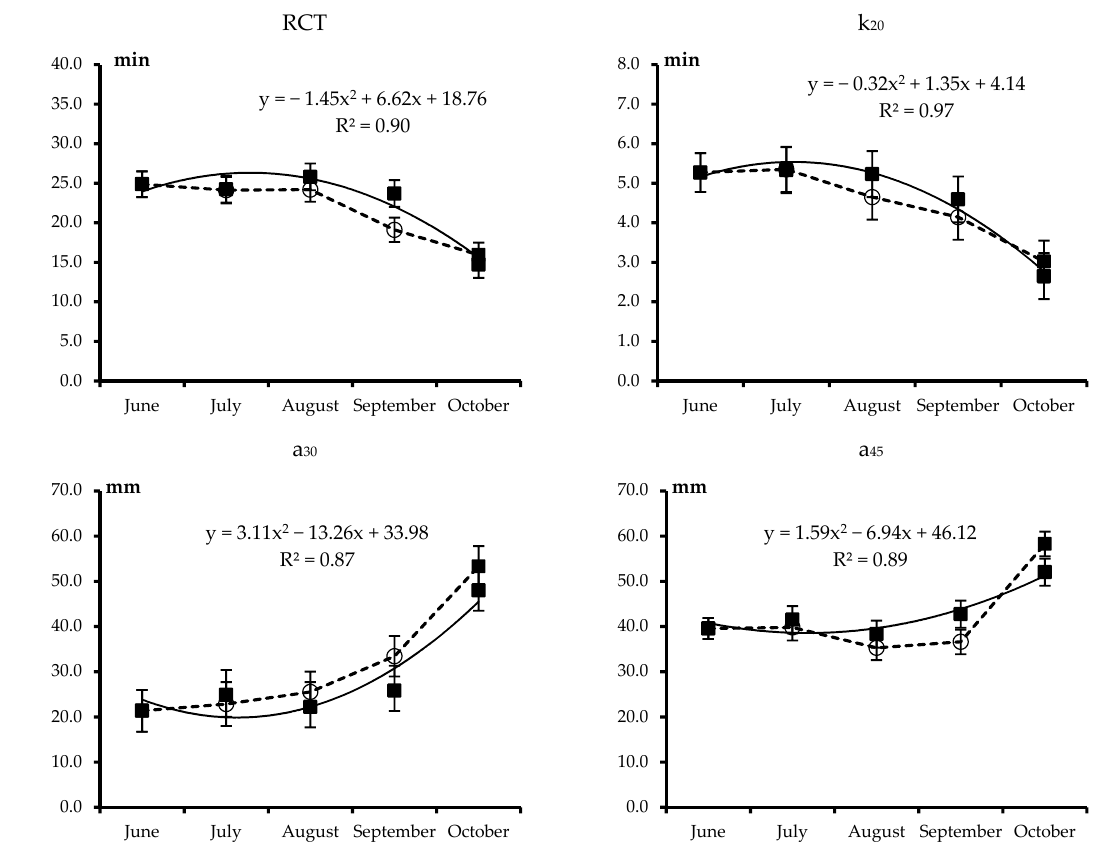
Figure 2. Least squares means and standard error of the combined Treatment × Month effect for milk coagulation traits (RCT: Rennet coagulation time, k 20 : Curd-firming rate as time to a curd firmness of 20 mm, a 30 and a 45 , respectively: Curd firmness after 30 and 45 min from rennet addition) of Brown Swiss cows kept on the permanent farm ( ■ and continuous line) or moved to highland summer pasture from July to September ( ○ and dotted lines). Equations describe the trends of month within permanent farm (R 2 is shown). Differences between cows moved to highland summer pasture and those kept on the permanent farm in a given month were never significant ( p > 0.05).